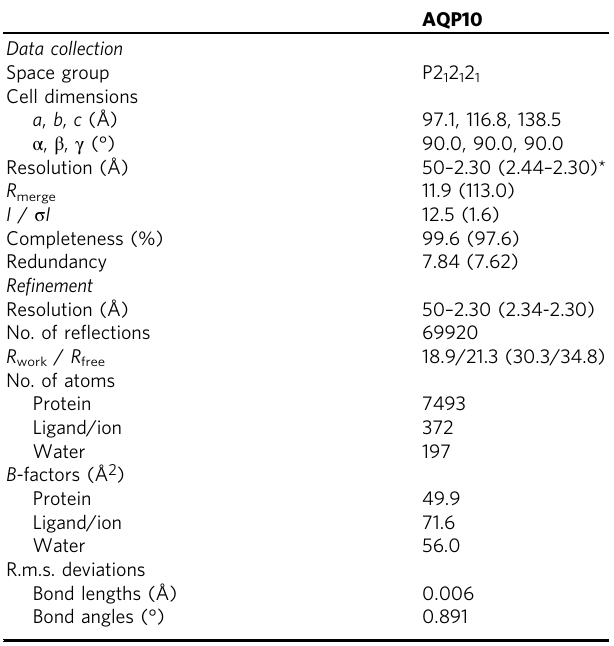
Table 1 Data collection and re fi nement statistics (molecular